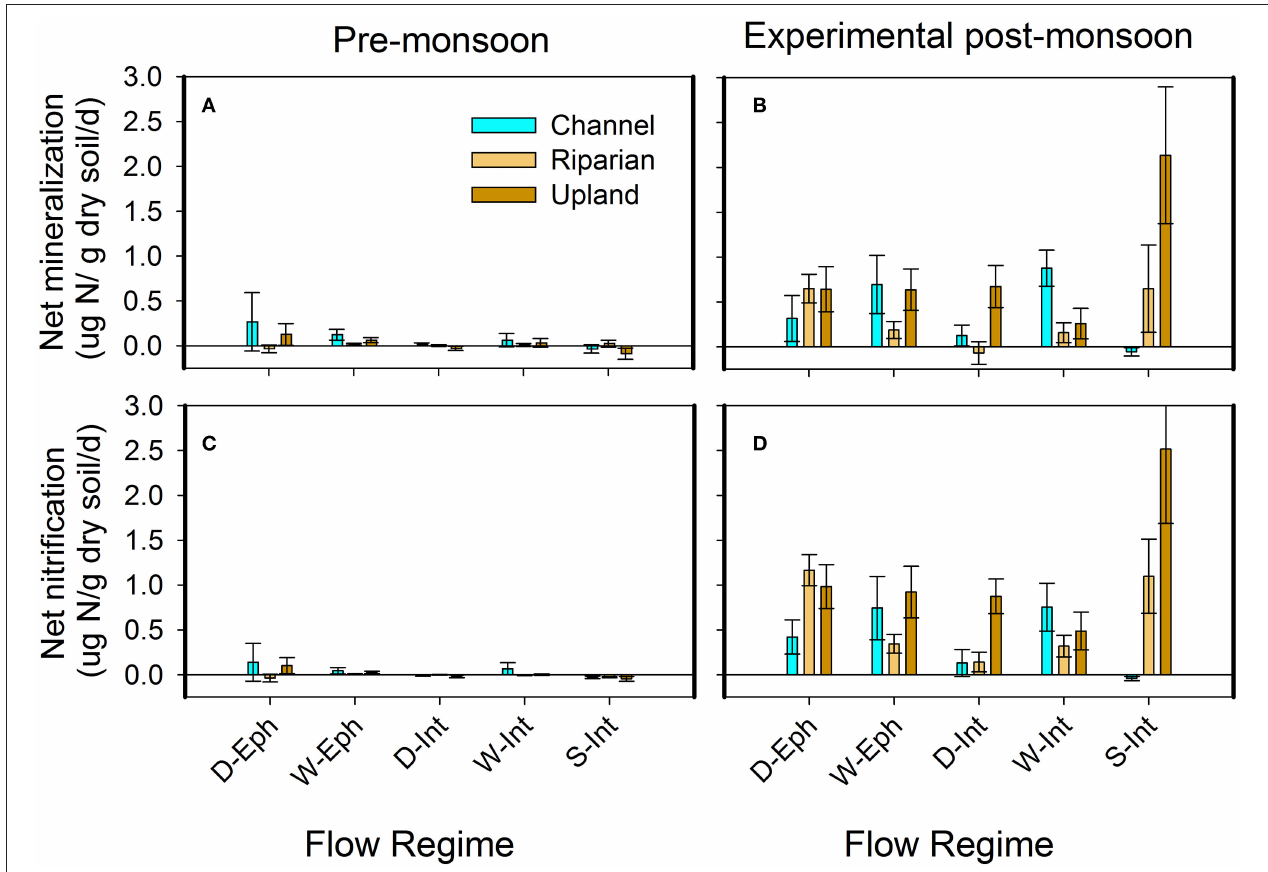
FIGURE 7 | Pre-monsoon rates of net mineralization (A) , potential rates of net mineralization in response to experimental wetting (B) , pre-monsoon rates of net nitrification (C) , and potential rates of net nitrification in response to experimental wetting (D) across flow regimes, D-Eph, Dry ephemeral; W-Eph, Wet-ephemeral; D-Int, Dry-intermittent; W-Int, Wet-Intermittent; and S-Int, Seasonally-Intermittent and positions.